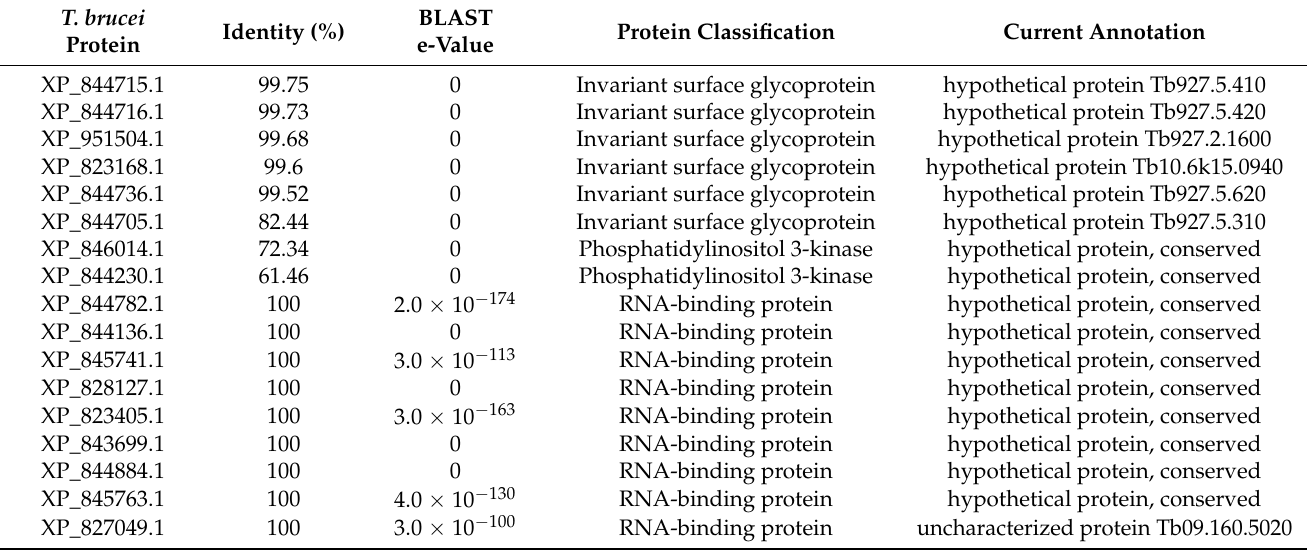
Figure 4. Genomic specificity of identified TbrMam genes when compared with the whole genome. ( A ) Comparison of coding sequencing length; ( B ) comparison of 3 ′ -UTR length; ( C ) comparison of GC content; ( D ) comparison of exon numbers, the red bars indicate the TbrMam protein, while the gray bars indicate the background proteins. The asterisk symbol indicated the significance of statistical genomic specificity in the figures. Table 2. The identified new pathogenic proteins in T. brucei . A total of 32 proteins were identified in this